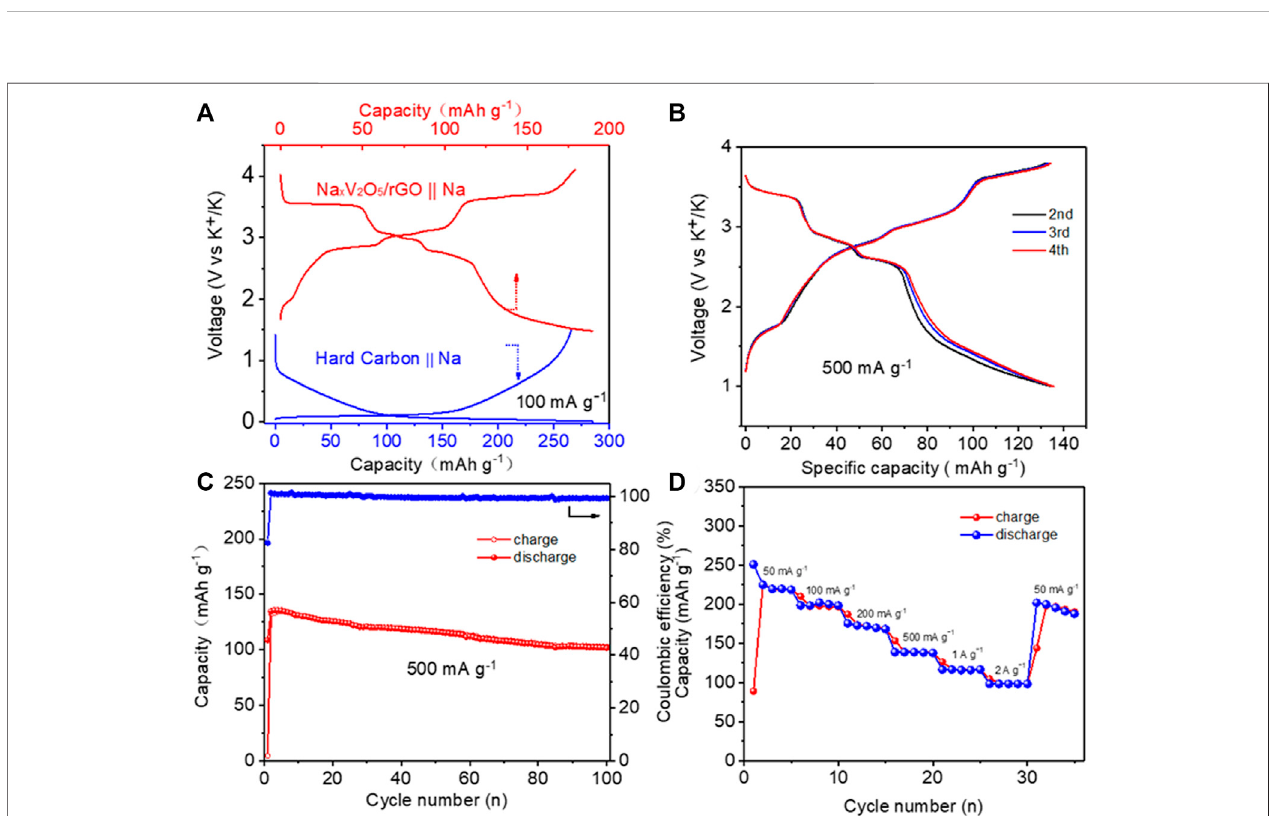
FIGURE 5 | Demonstration of SIBs based on Na x V 2 O 5 /rGO || hard carbon con fi guration. (A) Typical charge – discharge curves of Na x V 2 O 5 /rGO fi lm || Na and hard carbon||Nainahalf-cellcon fi guration; (B) Electrochemicalcharge – dischargevoltagepro fi lesofSIBs,cycledatacurrentrateof500 mA g − 1 ; (C) Cyclingperformanceof SIBs at a constant current of 500 mA g − 1 ; (D) Rate capability of SIBs at different current rates, increasing from 50 mA g − 1 to 2A g − 1 .